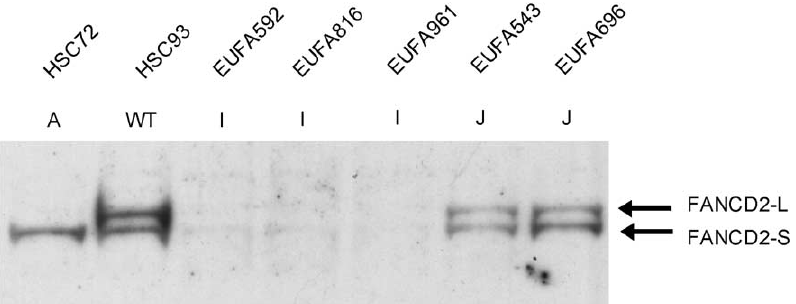
Fig. 4. In FA-J cells, both forms of FANCD2 (FANCD2-S and -L) are clearly detectable in nuclear extracts representing the chromatin fraction. In addition, in FA-I cells, both forms of FANCD2 (FANCD2-S and -L) are hardly detectable in the chromatin fractions of nuclear